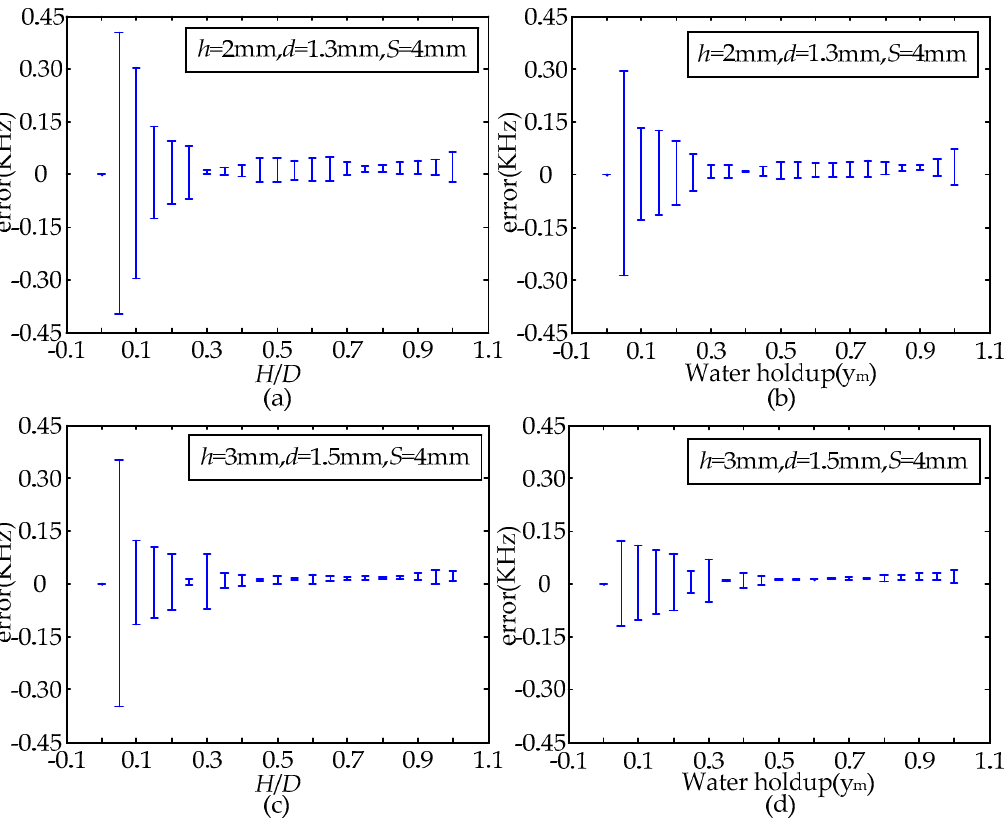
Figure 18. Error bars of the MCP with different structure parameters from two aspects of y m and H / D ( D = 20 mm, L = 50 mm): ( a,b ) h = 2 mm, d = 1.3 mm, S = 4 mm; ( c,d ) h = 3 mm, d = 1.5 mm, S = 4 mm.